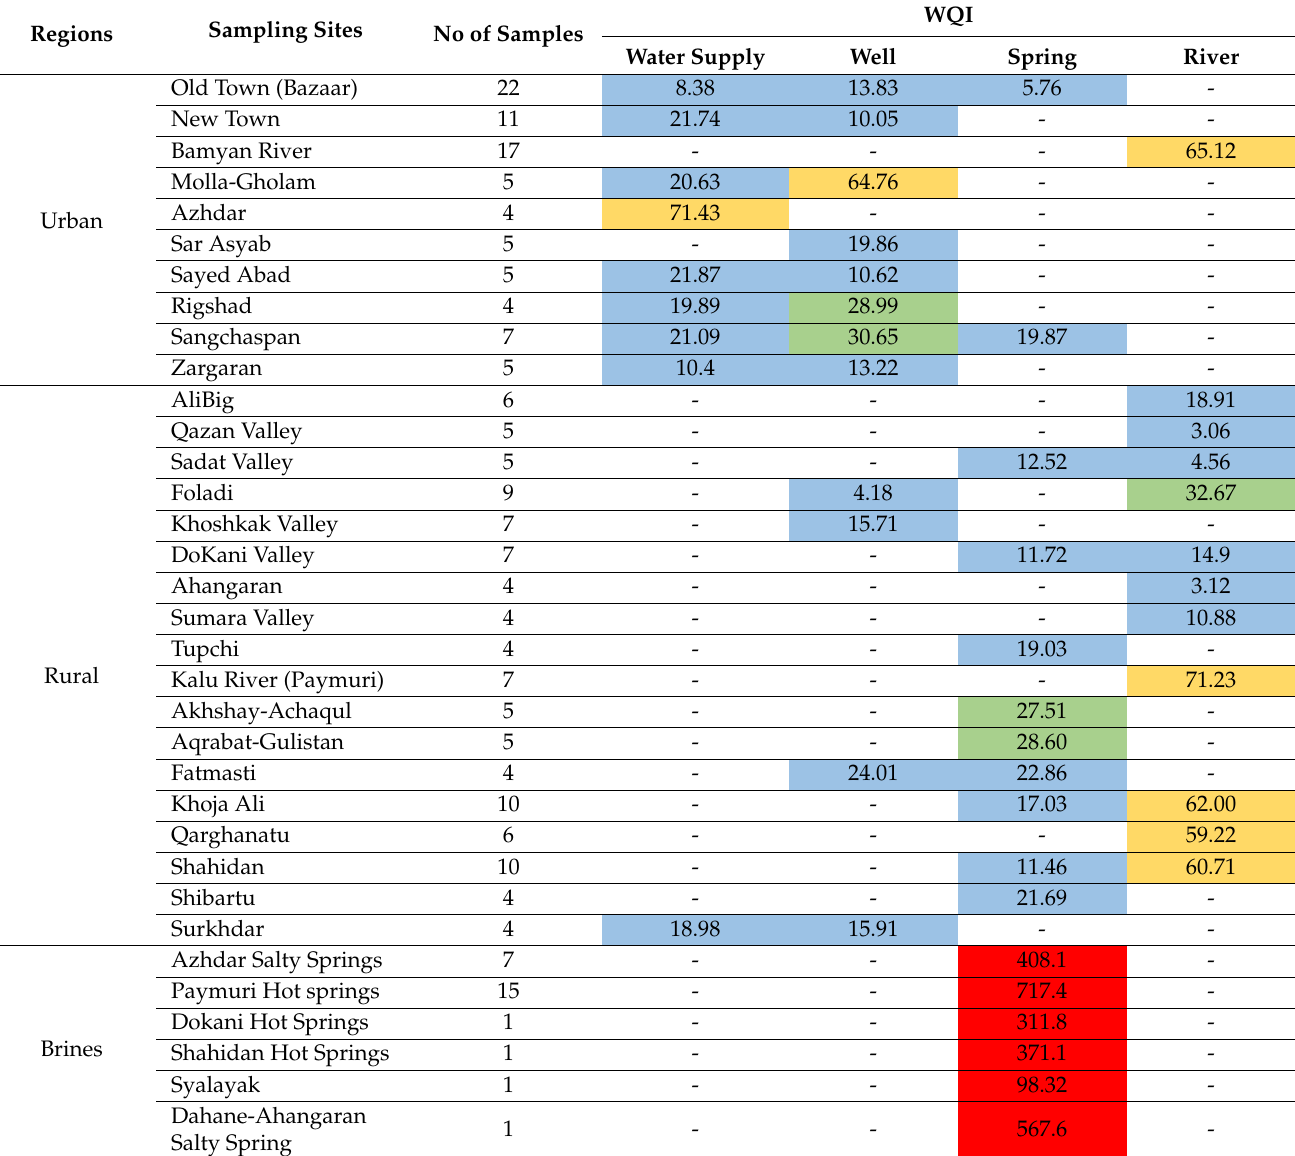
Table 5. General status of water samples and classification based on calculated WQI. Color coding reflects various WQI categories as noted in Table